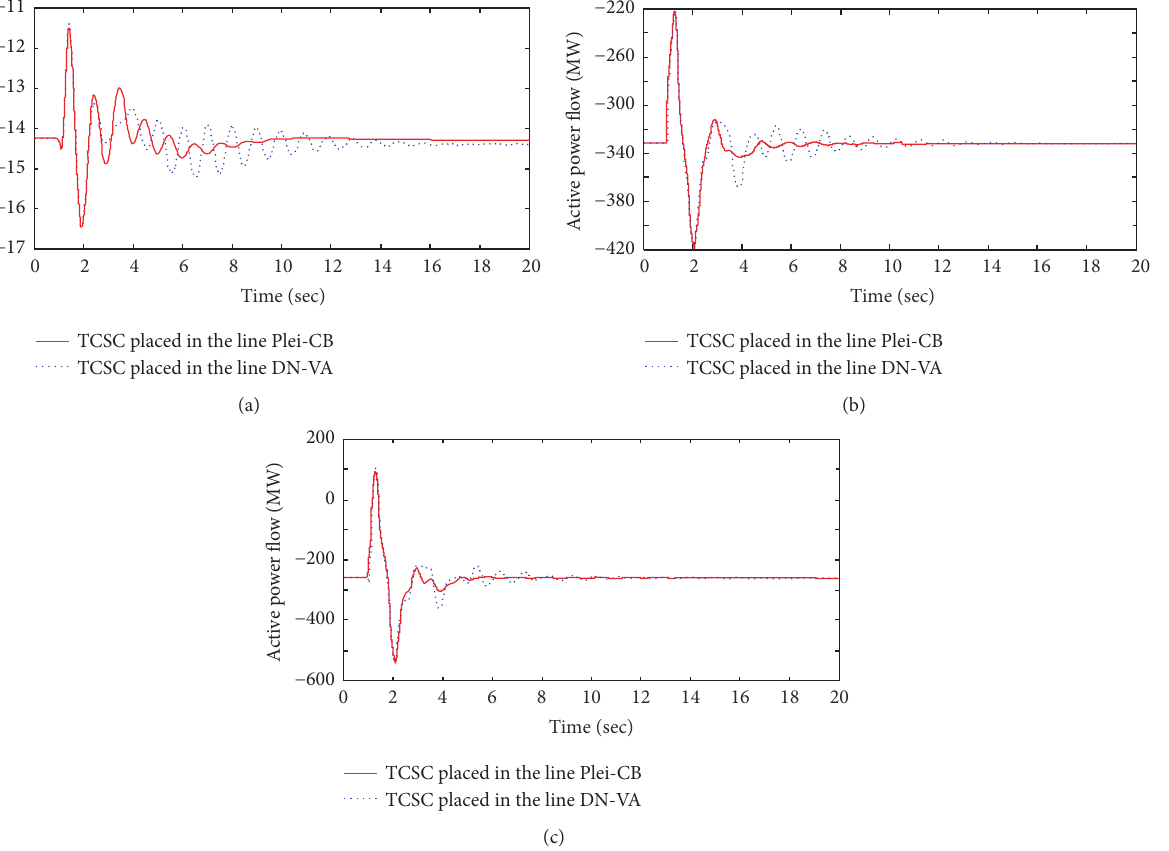
Figure 13: The transient response: (a) the relative angle oscillations of generator SonLa; (b) the active power oscillations in the line NhoQuan- SonLa; (c) the active power oscillations in the line HaTinh-VungAng.